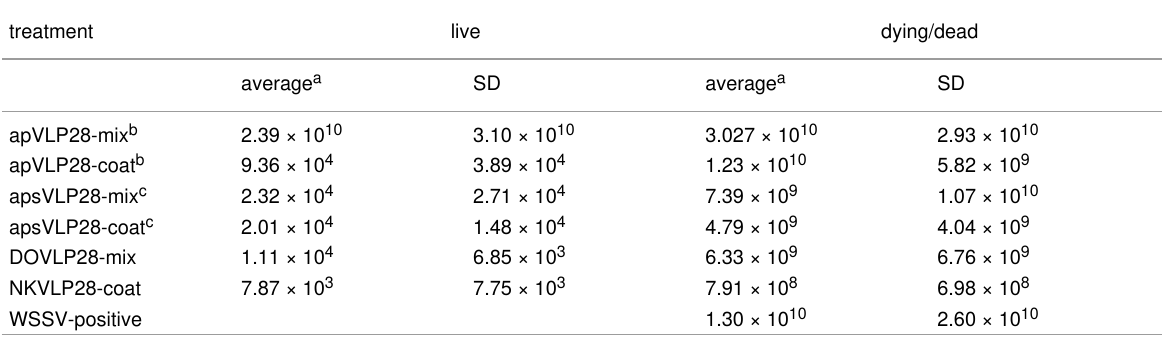
Table 1: WSSV copies in shrimp abdominal tissue by real-time quantitative PCR (qPCR). Average copies of WSSV in ng − 1 and SD values of shrimp treated with coated and mixed pellets using industrial-grade fish oil (ap), salmon fish oil (aps), and commercial binders (DO and NK).